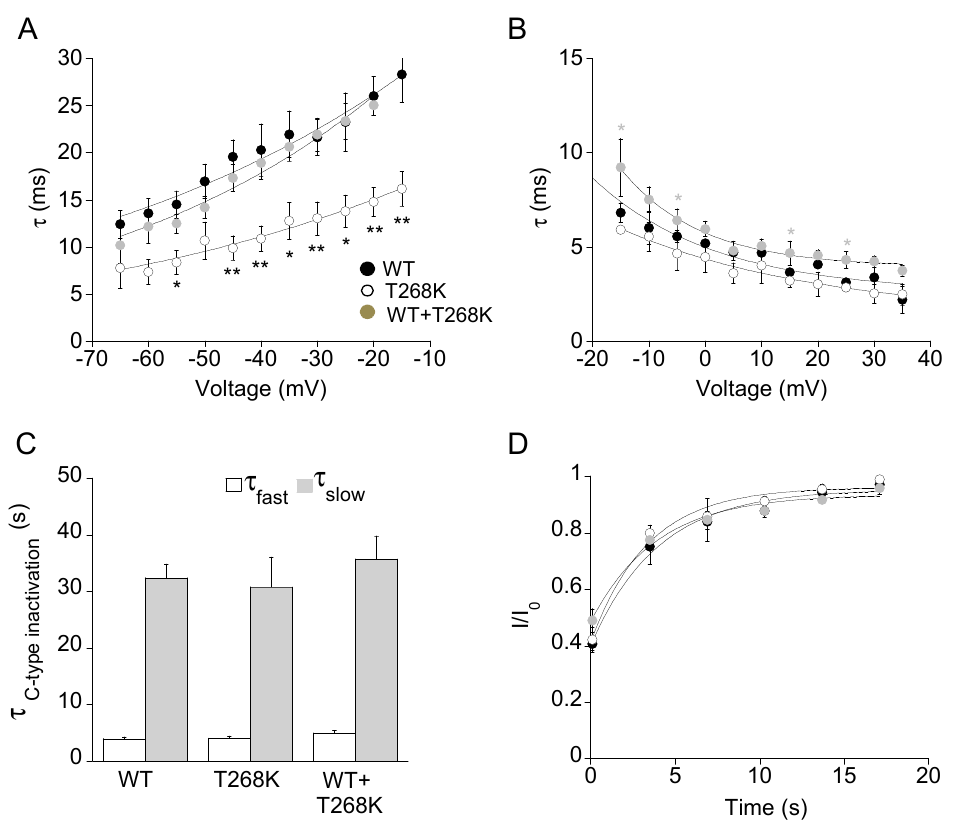
Figure 4. Deactivation ( A ) and activation ( B ) kinetics measured for the indicated channels. The time constants, resulting from the fit of the activating and deactivating current traces with a single exponential function, were plotted as a function of voltage ( n = 10–19 cells), * p < 0.05, and ** p < 0.01 with respect to WT for T268K (black) and WT+T268K (gray), respectively. ( C ) Bar graphs showing the fast (white) and slow (gray) time constants of the C-type inactivation for the indicated channels calculated by fitting current decay with a double exponential function ( n = 9–11 cells). ( D ) Recovery from C-type inactivation. The solid curves indicate the fit of the data points with an exponential function from which the time constants were calculated for the indicated channels ( n = 6–10 cells).